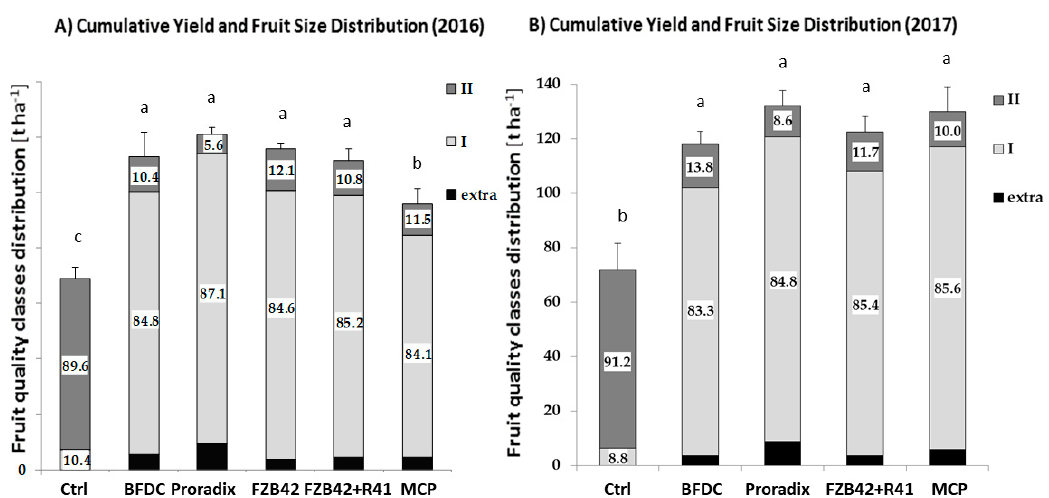
Figure 2. Cumulative yield (t ha − 1 ) and fruit size distribution (t ha − 1 and %) for greenhouse tomato production with different BS treatments in 2016 ( A ) and 2017 ( B ). Quality classes (g FW fruit − 1 ): extra-large: >200 g, class I: 150–200 g, and class II: <150 g. Columns represent mean values of cumulative fruit yield ± SD ( n = 4). Significant treatment differences in cumulative yield (Tukey test, p ≤ 0.05) are indicated by different characters.